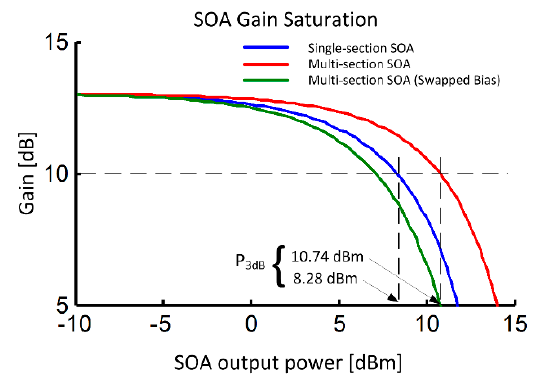
Figure 5. SOA gain saturation curves for the regular single-section SOA (blue) and multi-section SOA in red. The multi-section SOA is biased so that the P 3dB is greater and increases from 8.28 dBm for the single-section SOA to 10.74 dBm for the multi-contact SOA. We find that the results show similar performance to single section and multi section SOAs in [10,11]. The green curve shows the gain saturation characteristic when the bias to the first and third sections are swapped; in this scenario the effective gain saturation is much stronger resulting in a P 3dB of 7.1 dB.